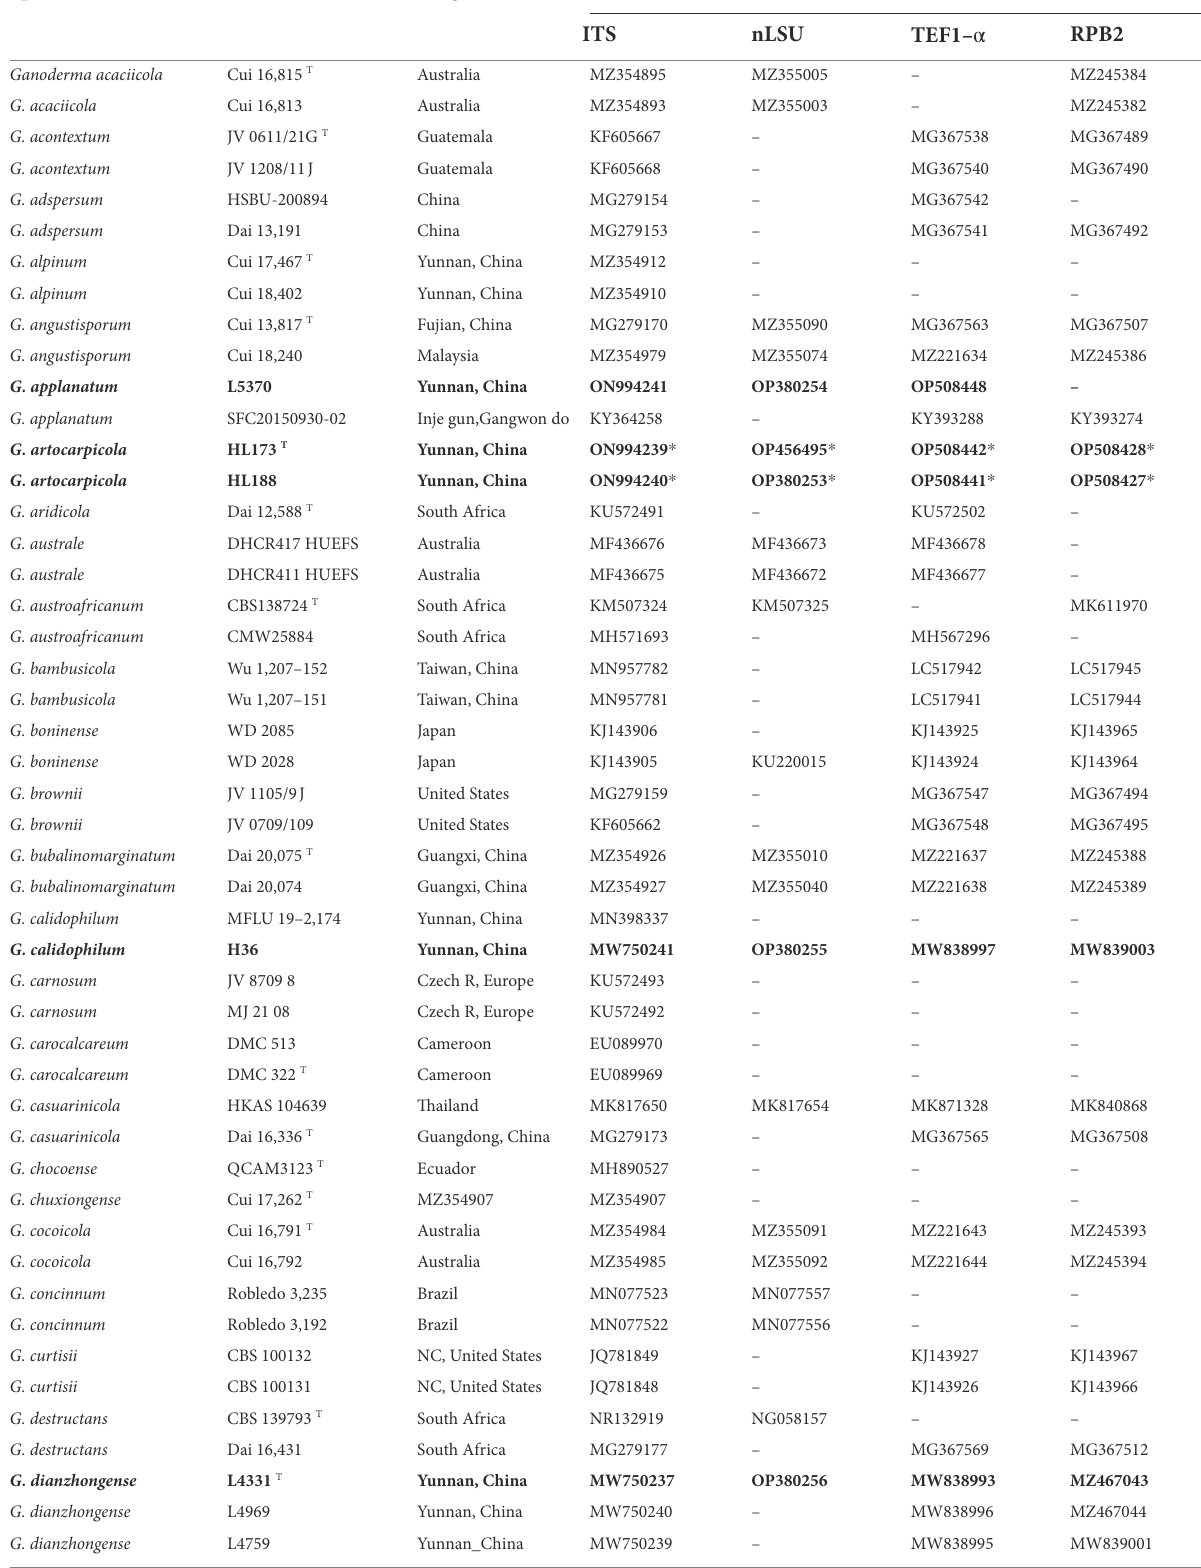
TABLE 2 Specimens used for phylogenetic analyses and their corresponding GenBank accession numbers.